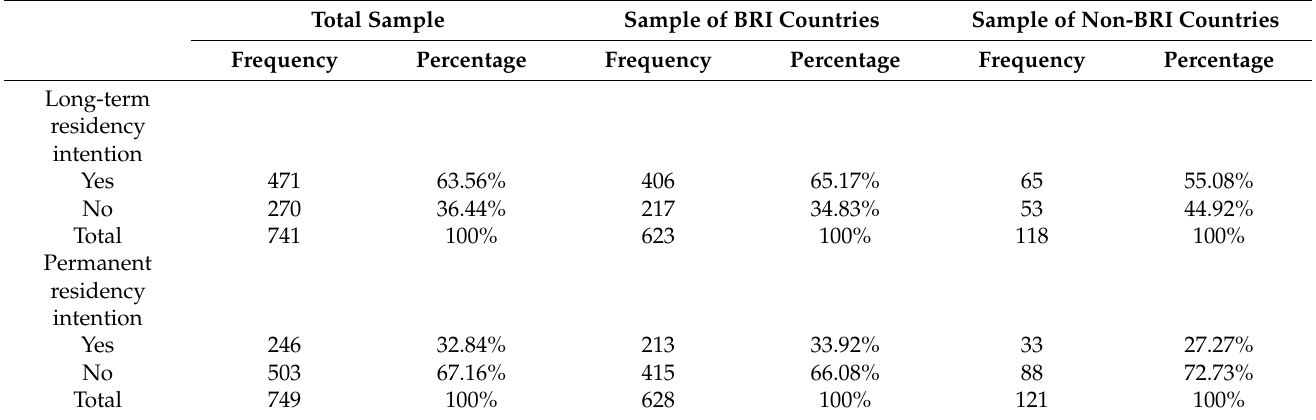
Table 4. Distribution of residence intentions of foreigners in Xi’an.